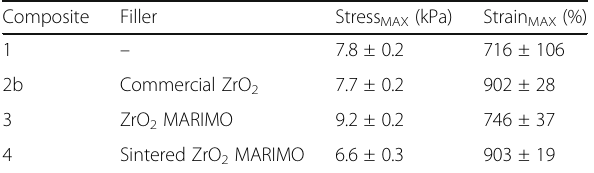
Table 2 Tensile strengths and elongation capacities of 30 wt%